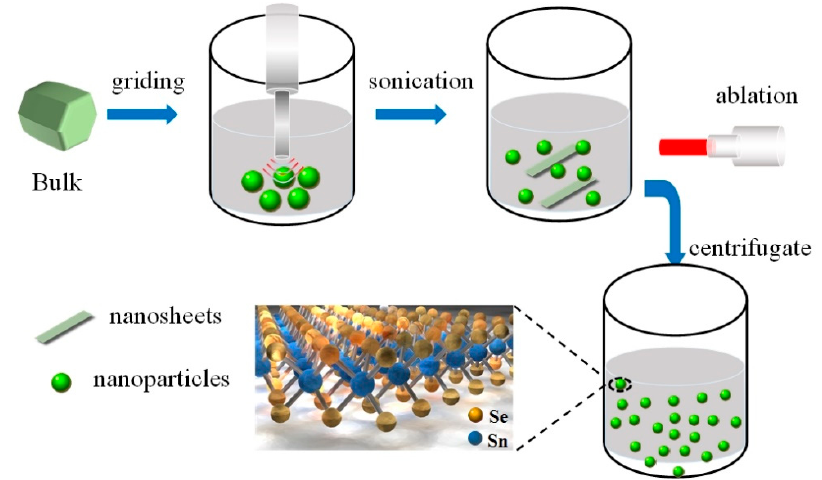
Figure 1. Schematic show of the SnSe 2 structure and the quantum dot (QD) fabrication process.